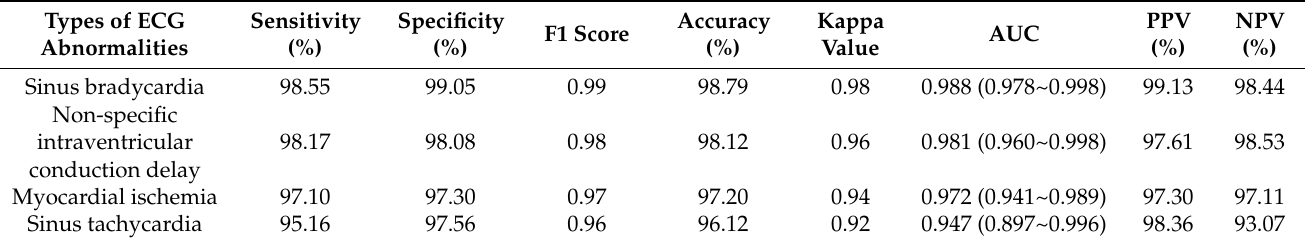
Table 7. Evaluation of the effect of ECG category recognition training